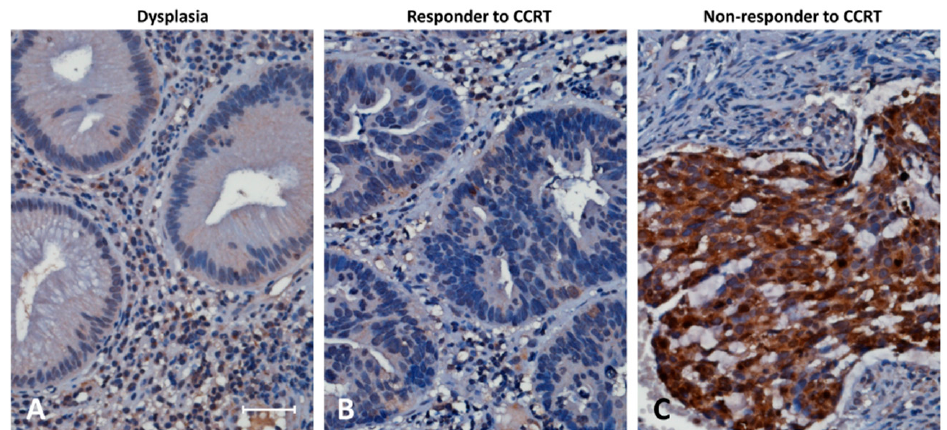
Figure 2. Higher SPINK4 immunoexpression was observed among CCRT nonresponders. Immunohistochemical staining was performed with an anti-SPINK4 antibody. Rectal dysplasia ( A ) revealed no expression of SPINK4. Tumor tissues showed low SPINK4 immunoexpression among CCRT responders and ( B ) high SPINK4 immunoexpression among CCRT nonresponders. ( C ) Scale bar, 100 µm.